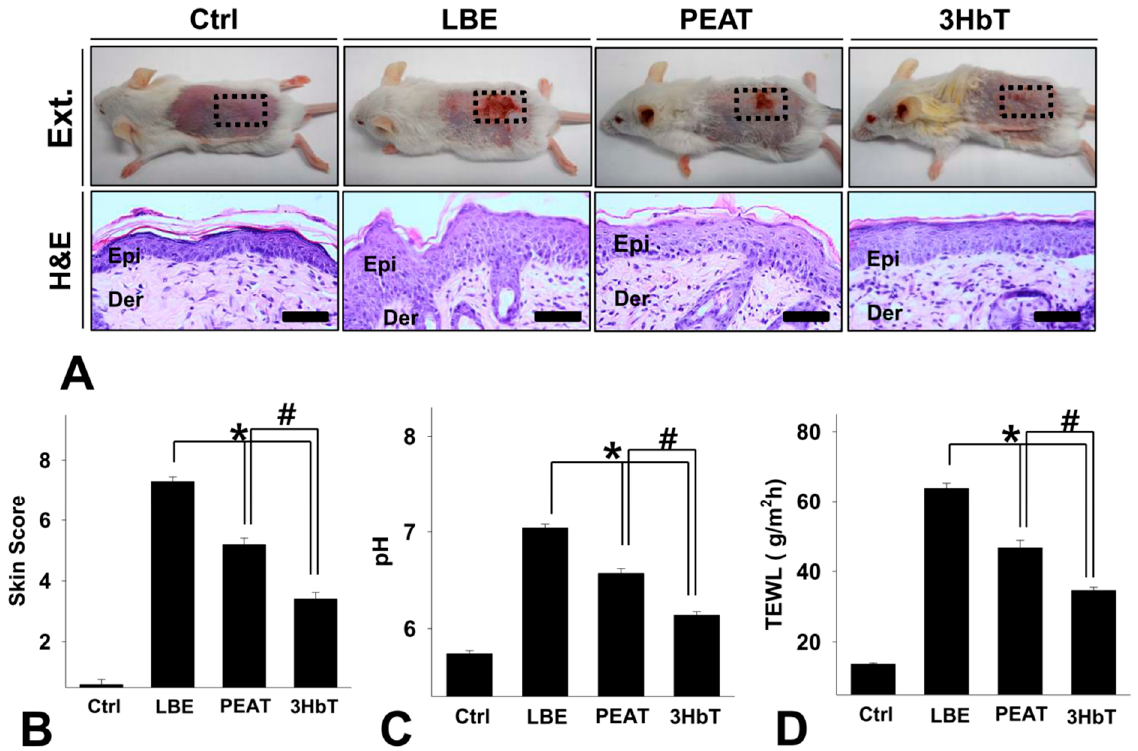
Figure 3. The alleviation of symptoms of lipid barrier elimination using Three Herb (3Hb) extract. ( A ) The alleviation of symptoms of lipid barrier elimination. The lipid destruction-induced skin lesions were relieved in 3HbT compared to PEAT and LBE. Clinical skin score ( B ), pH ( C ) and TEWL ( D ) was significantly lower in 3HbT compared with PEAT and LBE (Immunohistochemistry; bar size, 50 µm). 3Hb, Rhizome of Coptis chinensis , Rhizome of Glycyrrhiza uralensis , and fermented Semen of Glycine max ; Ctrl, the normal group; LBE, lipid barrier elimination group; 3HbT, 3Hb treated group after lipid barrier elimination; Ext., External morphology; H&E, Hematoxylin and Eosin stain; Epi, epidermis; Der, dermis; * p < 0.05 compared to LBE; # p < 0.05 compared to